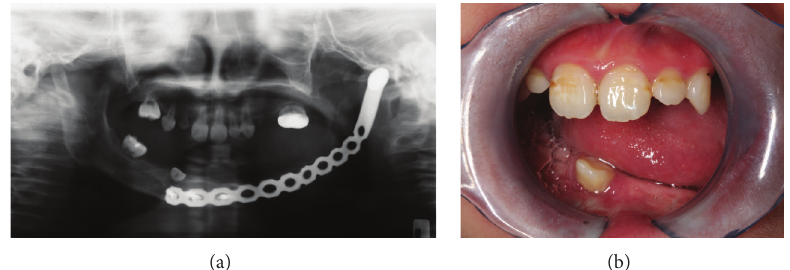
Figure 1: (a) Surgical resection involving part of the mandible in a patient with rhabdomyosarcoma. (b) Limited mouth opening after surgical